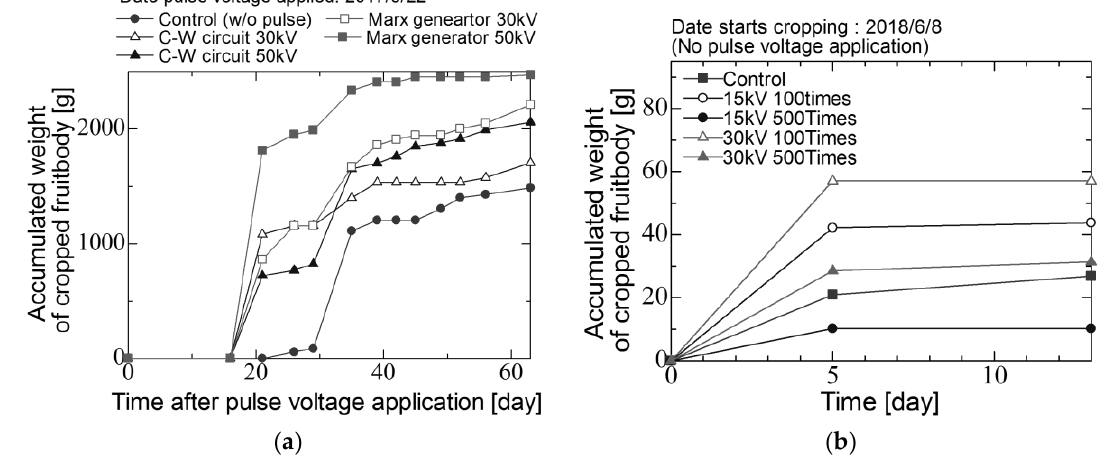
Figure 12. Electric field distribution inside of Lyophyllum deeastes Sing. Sawdust block for applied voltage of 30 kV.